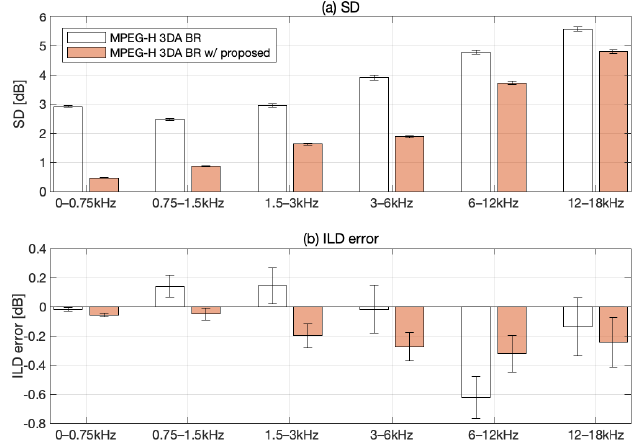
Figure 6. Measurement results of ( a ) SD and ( b ) ILD error with a 95% confidence interval, measured in octave